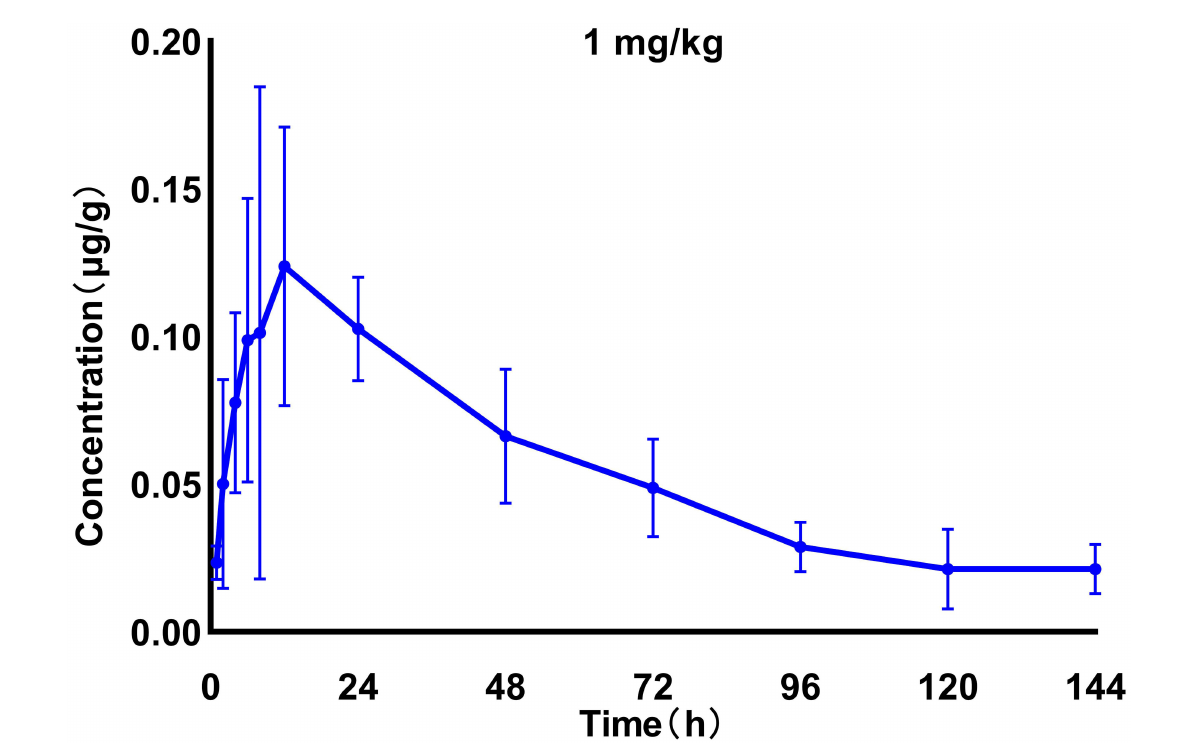
FIGURE2 Time–concentration curves of tilmicosin in lung tissues after oral administration of 1 mg/kg in infected M. gallisepticum chickens ( n = 8/time point).